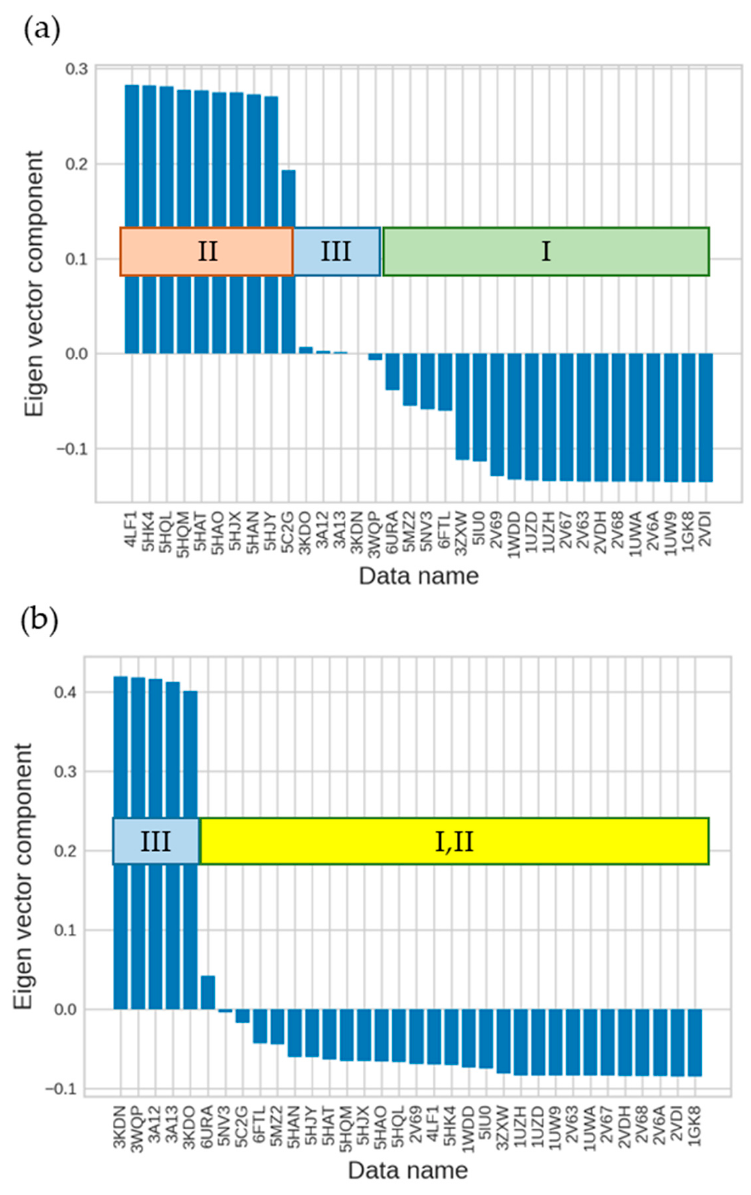
Figure 6. Results of SVD analysis for the right-singular vectors of IFIE matrix. ( a ) The second and ( b ) third right-singular vectors for each structure dataset identified by PDB entry. The corresponding isoforms I–III are also indicated. Table 1. Top eight sites with the largest absolute values of eigenvector elements in the first, second, and third left-singular vectors of SVD.